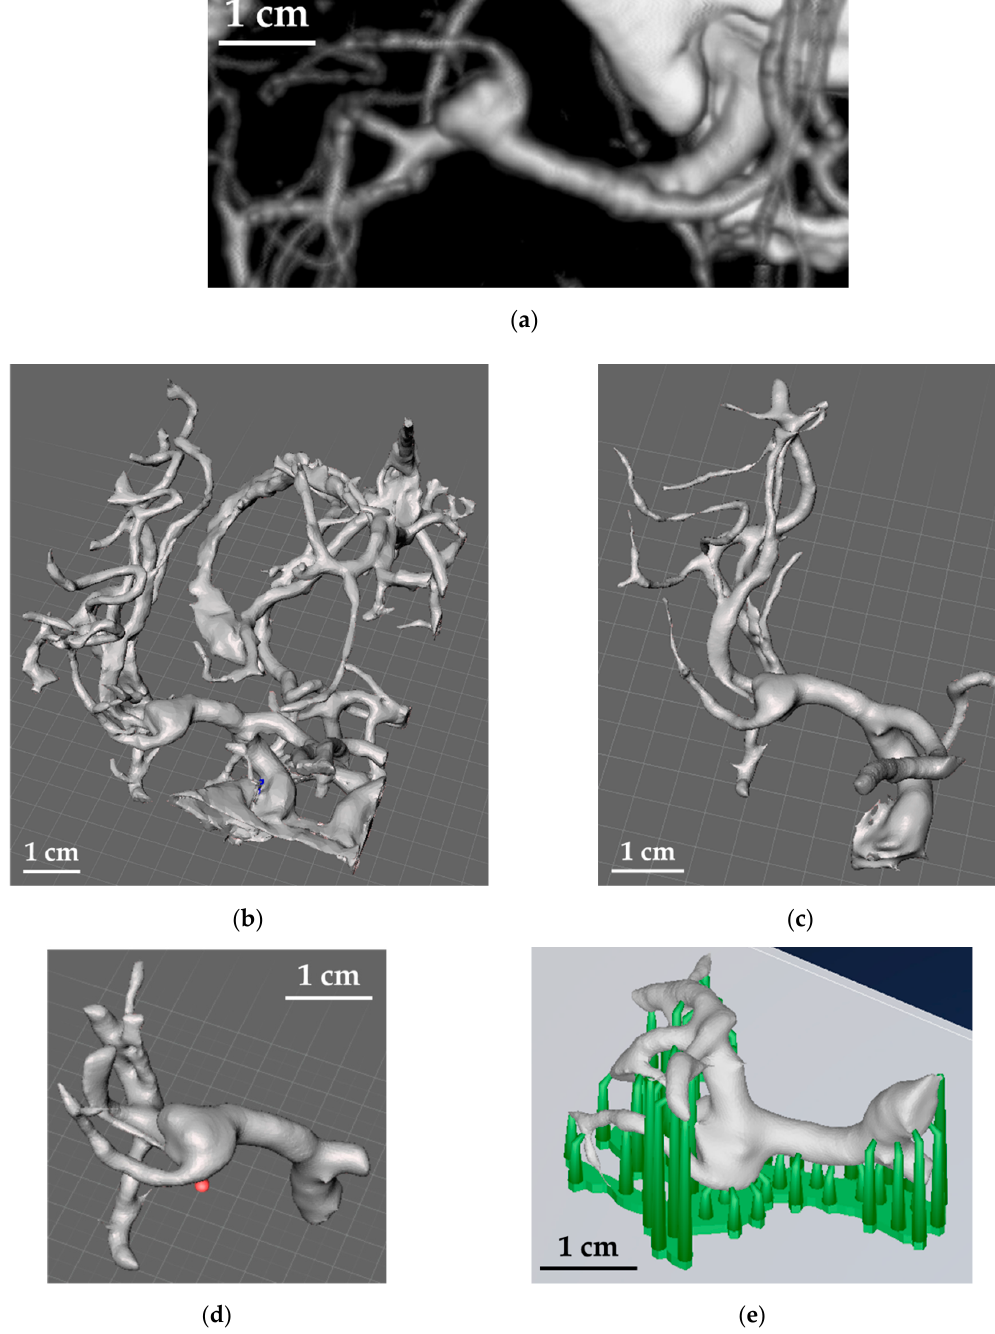
Figure 2. Elaboration of the STL file starting from the DICOM image of a cerebral aneurysm structure: ( a ) CTA image; ( b ) conversion to the first STL file; ( c ) first simplification of the model; ( d ) second simplification of the model in order to be limited to the surrounding of the aneurysm to speed up the printing process; ( e ) creation of the supports (green structures) and slicing.